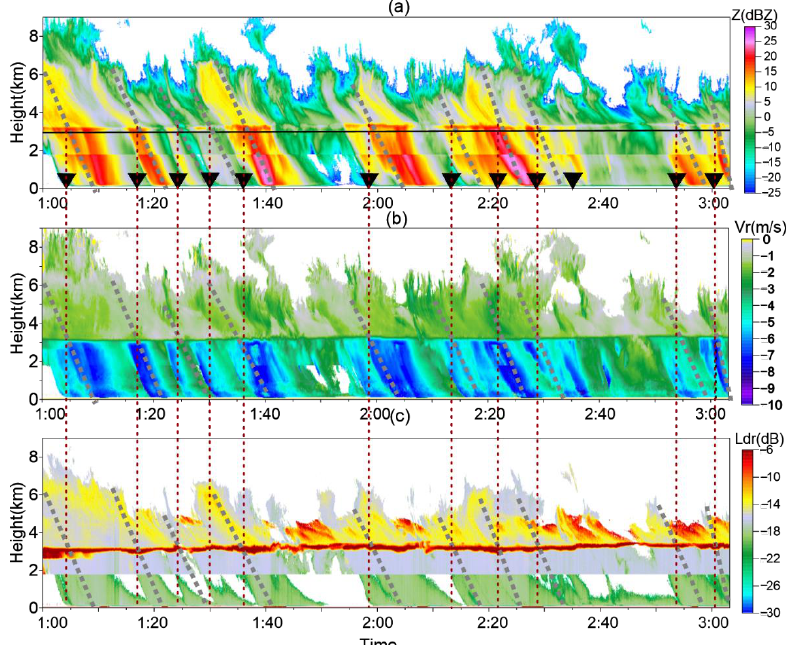
in the lower layer; therefore, the clouds were tilted. We used gray dotted lines to roughly mark the tilted structure of the clouds that contained convection.